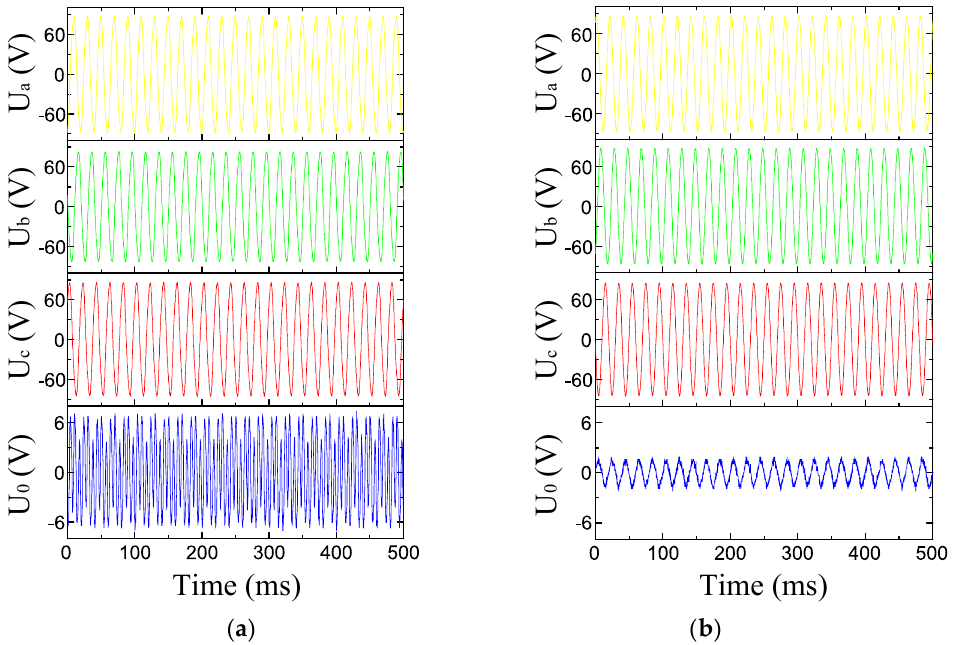
Figure 7. Test results for the VT secondary voltage waveform. ( a ) Normal insulation; ( b ) insulation in breakdown.